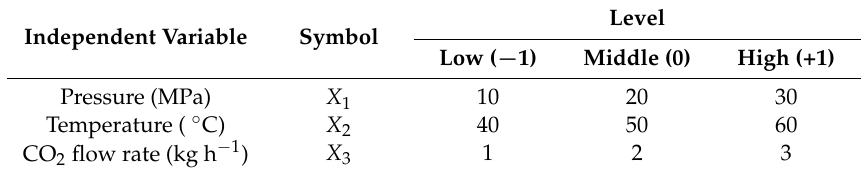
Table 1. Coded and real levels of independent variables for the designed experiment.